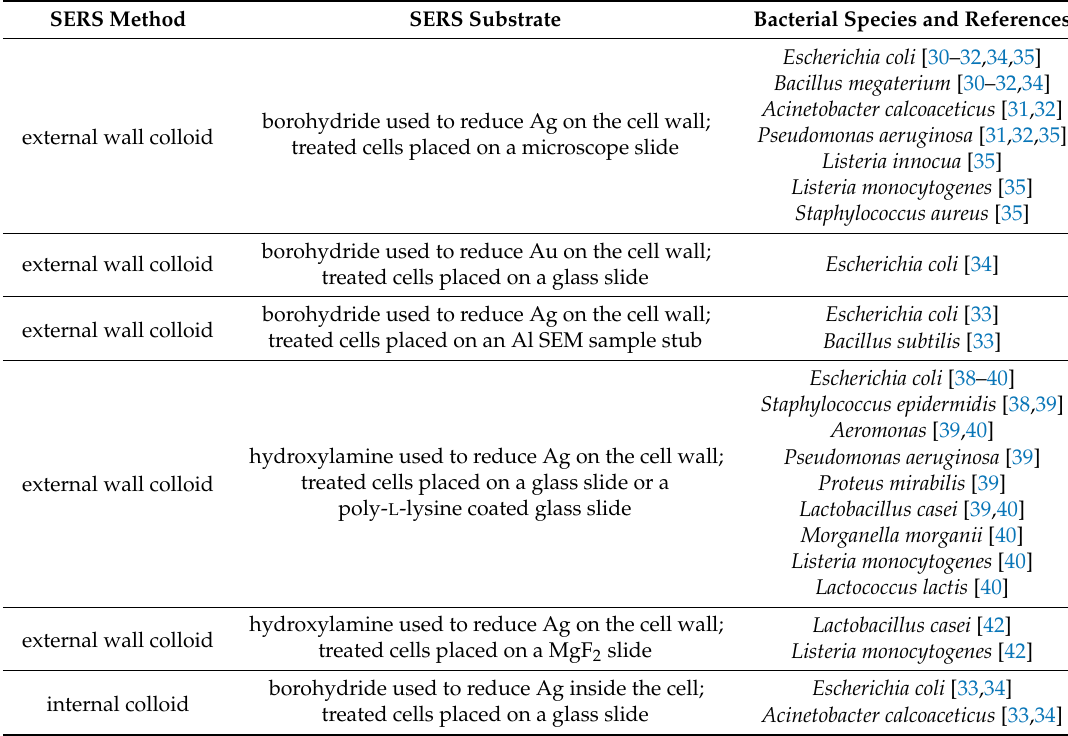
Table 1. Summary of bacteria detected using either external wall or internal colloids that were discussed in this